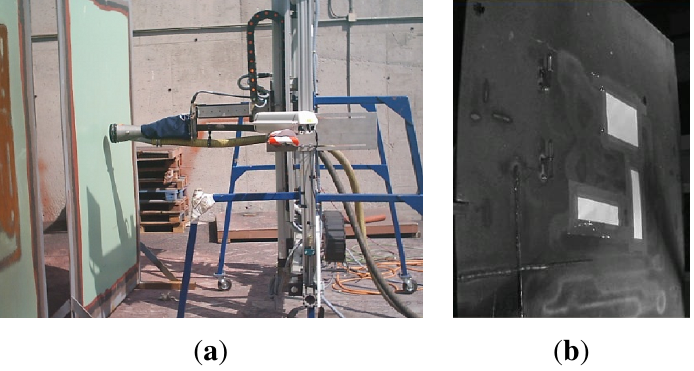
Figure 9. XYZ Table. ( a ) Position of the camera in the left frame of the table; ( b ) An example of a distorted